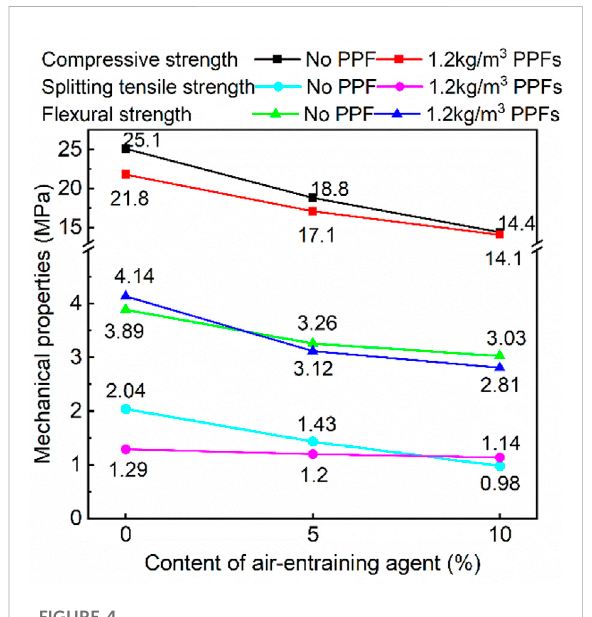
FIGURE 4 Effect of air-entraining agent on mechanical properties.